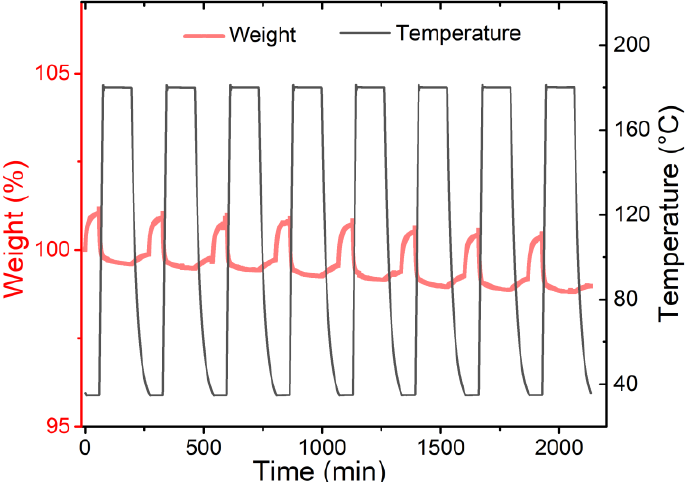
Figure 7. CO 2 adsorption and desorption cycle curves of